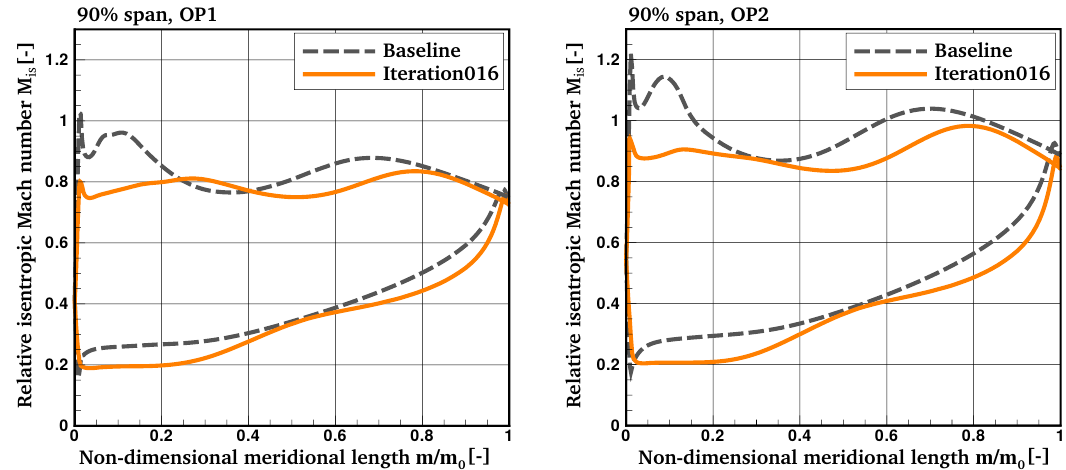
Figure 14. Relative isentropic Mach number on the blade surface at 90% span of the baseline and the optimized geometry (Iteration016) at operating point OP1 ( left ) and OP2 ( right ).